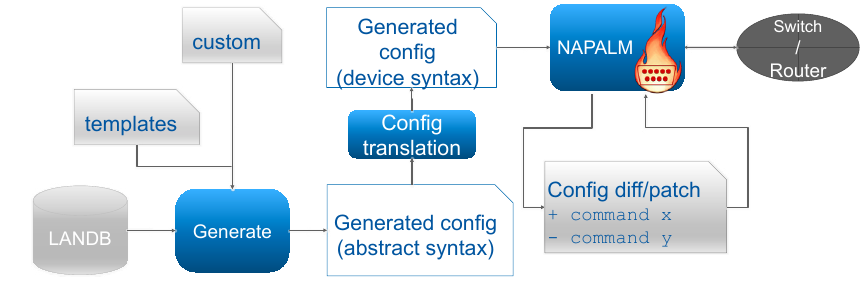
Figure 4: Evolved network configuration